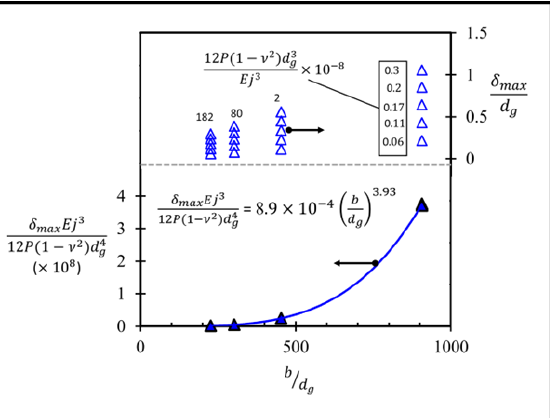
Figure 22. Variations of three dimensionless parameters in the case of sensor with annular groove 𝐴𝐺 − 𝑇𝑜𝑝 .